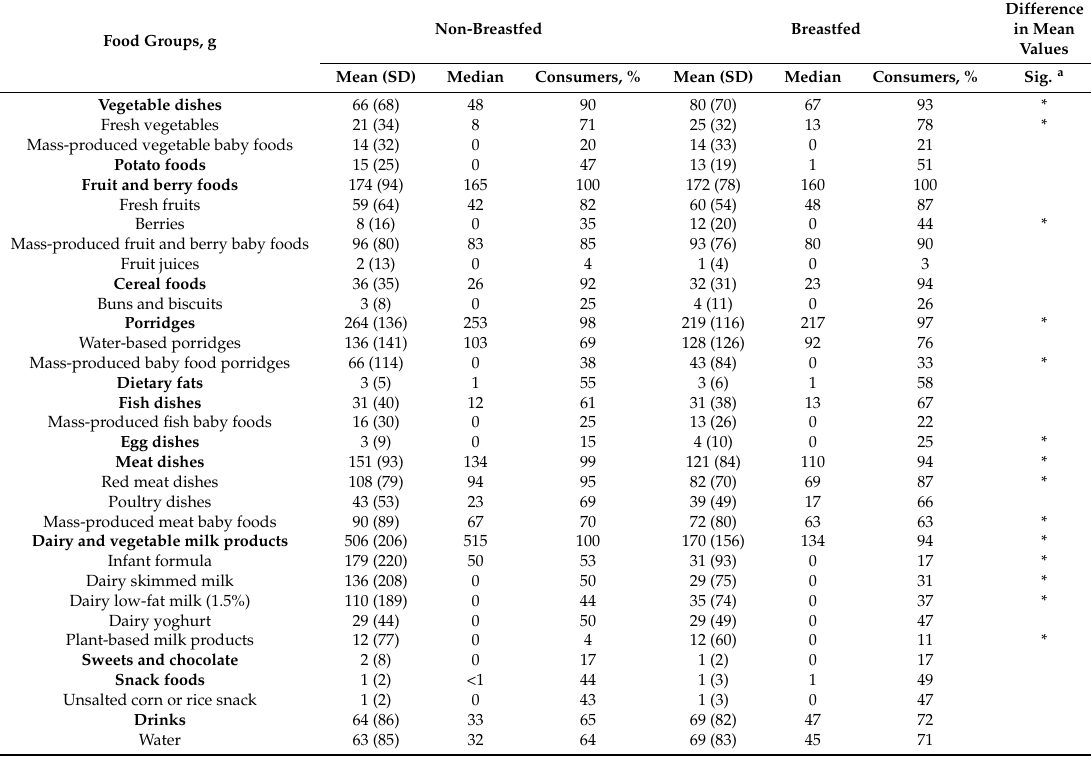
Table 2. Mean and median daily food intake (g) and percentages of consumers in non-breastfed ( n = 476) and breastfed ( n = 263) 1-year-old infants.